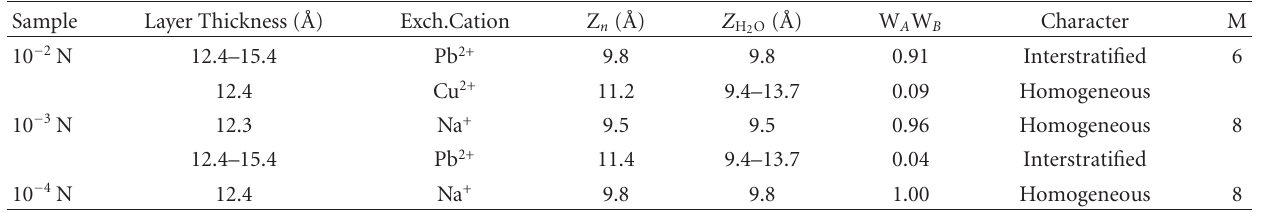
Table 2: Structural parameters deduced from quantitative XRD analysis. Exch.cation: exchangeable cations, Z n : coordinates of the ( ˚A): coordinate exchangeable cations (i.e., the origin of these coordinates was placed on the plane of surface Oxygen atoms [27]), Z H 2 O of the water molecule sheets, M: the number of layers per stack W A , W B : abundances of the di ff erent types of layers. Sample Layer Thickness ( ˚A) Exch.Cation Z n ( ˚A) Z H ( ˚A) W A W B Character M 2 O 10 − 2 N 12.4–15.4 Pb 2+ 9.8 9.8 0.91 Interstratified 6 12.4 Cu 2+ 11.2 9.4–13.7 0.09 Homogeneous 10 − 3 N 12.3 Na + 9.5 9.5 0.96 Homogeneous 12.4–15.4 0.04 Interstratified 10 − 4 N 12.4 Na + 9.8 9.8 1.00 Homogeneous